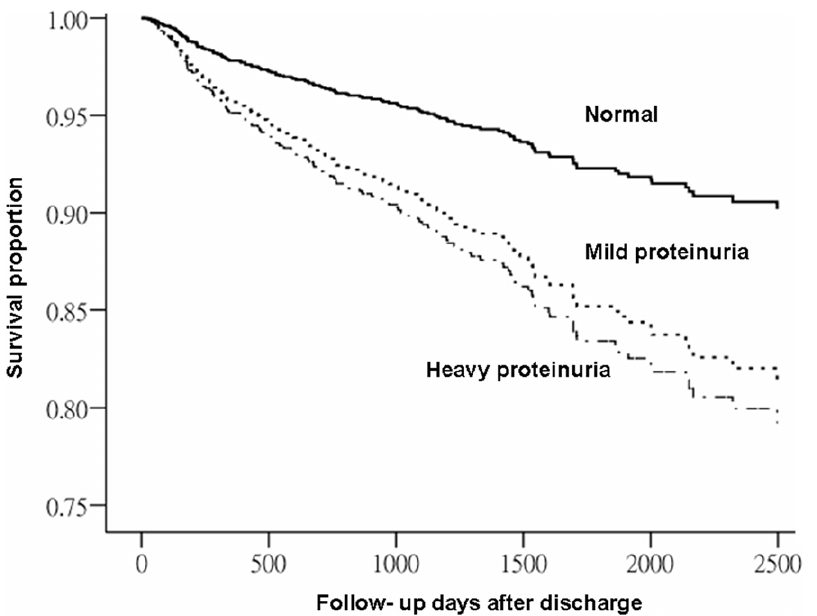
Figure 2. Adjusted risk for long- term all- cause mortality after hospital discharge stratified by different severities of proteinuria defined by preoperative dipstick. (Mild porteinuria, p=0.005; Heavy proteinuria, p=0.008; no proteinuria was the reference calculated by